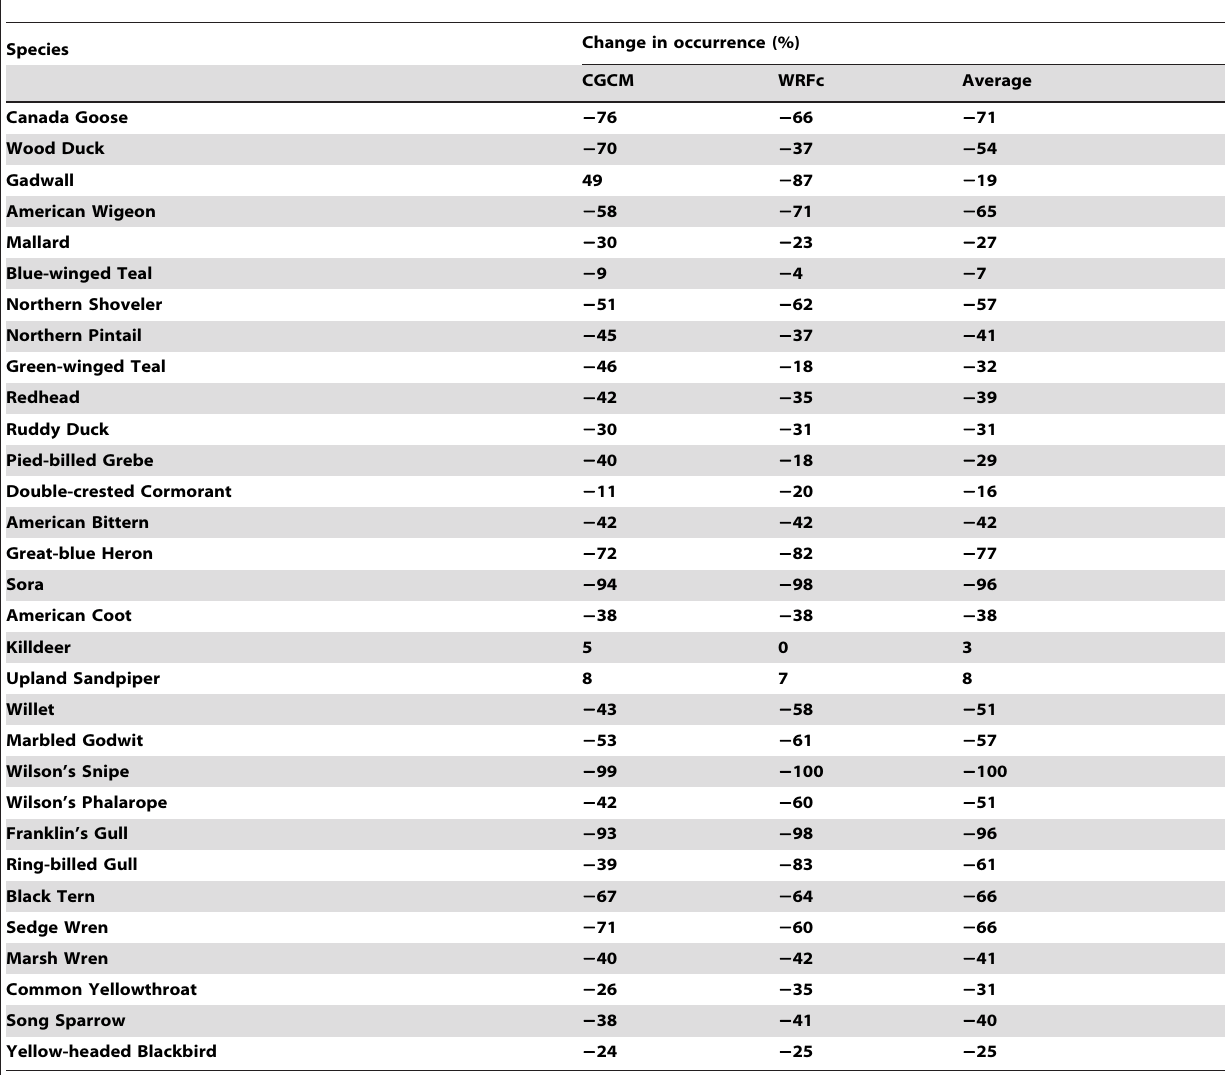
Table 3. Values report projected changes in occurrence in the 2040’s, relative to 1981–2000